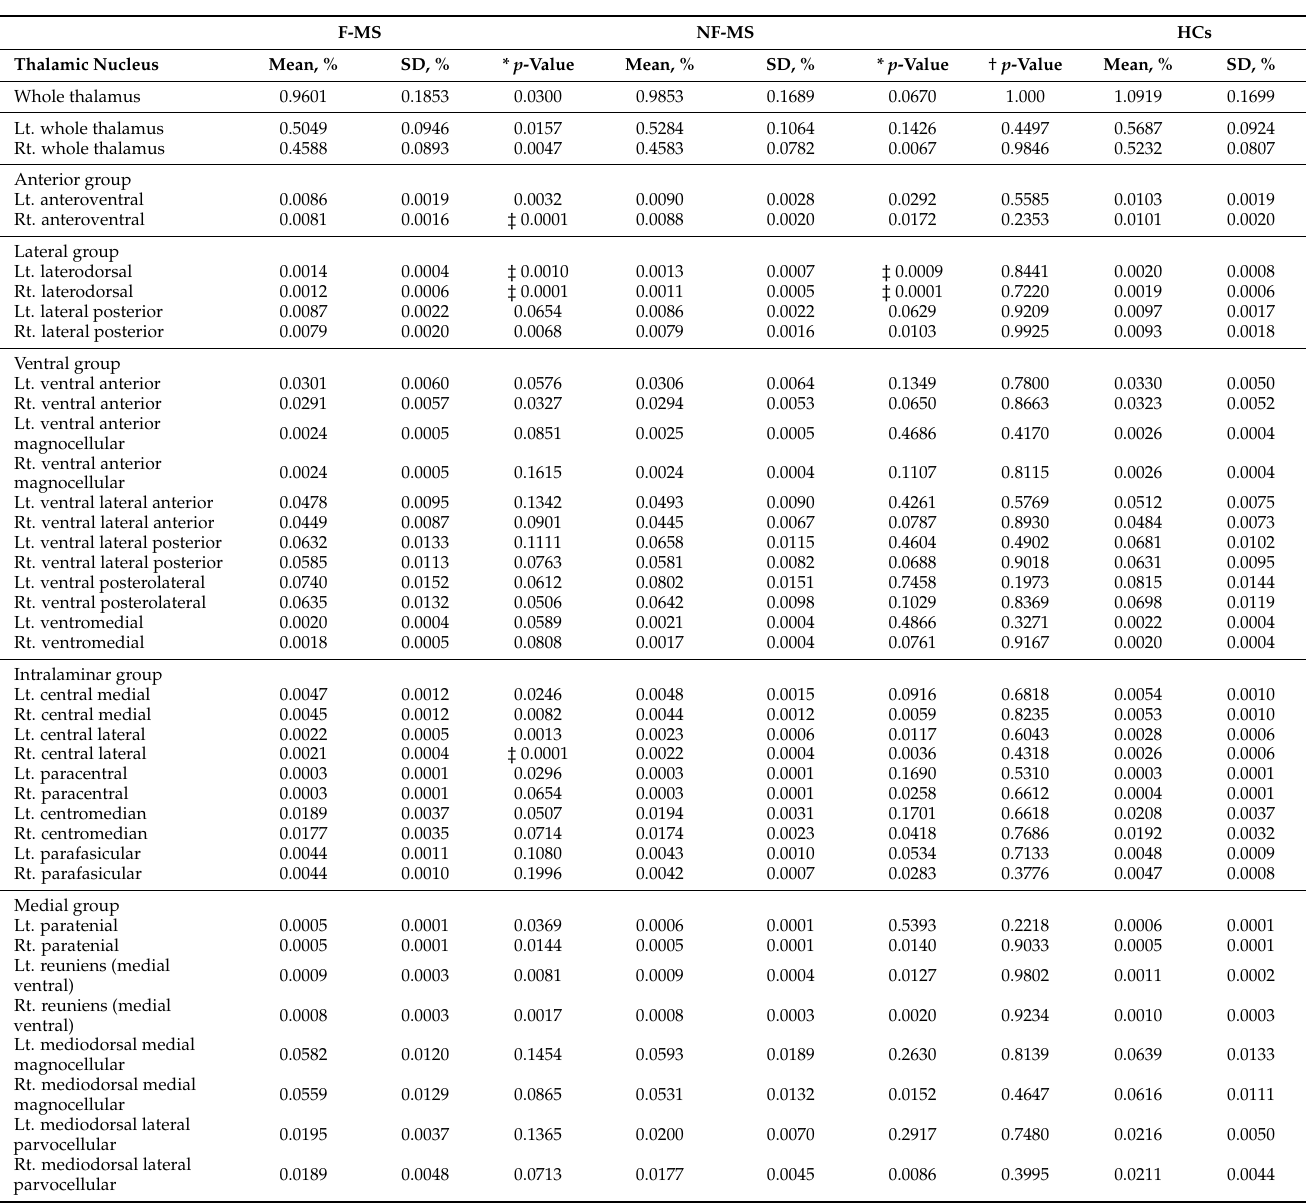
Table 2. Differences in the individual thalamic nuclei volumes among the F-MS, NF-MS, and HC